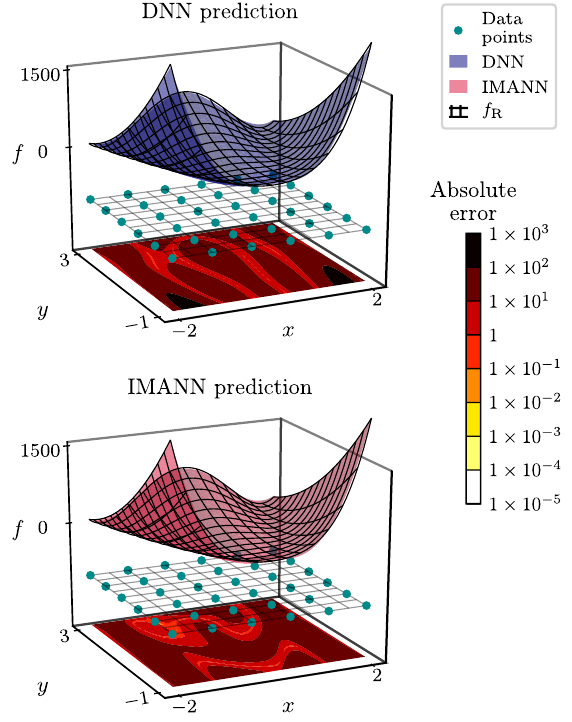
Figure 12. Rosenbrock function prediction with DNN and IMANN for 36 data points. Surfaces correspond to predicted values, wireframe to original function, blue points indicate data points and colormap on the bottom indicates absolute error.